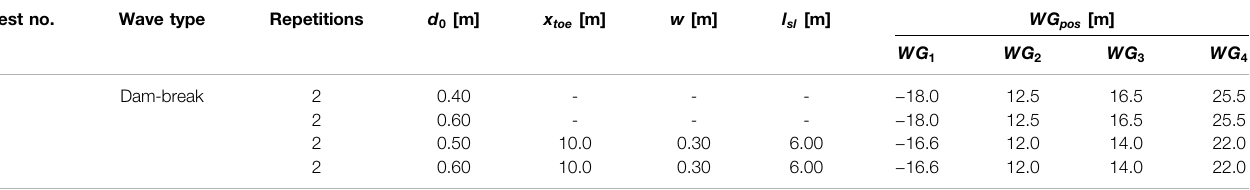
TABLE 1| Experimentalprotocol. Variablesand coordinates correspond to Figure2 .Impoundmentdepth d 0 ,thedistance betweengateand toeoftheslope x toe ,lengthof the slope l sl , and height of the horizontal plane w . The positions of the wave gauges are given in the fl ume ’ s coordinates. Test no.